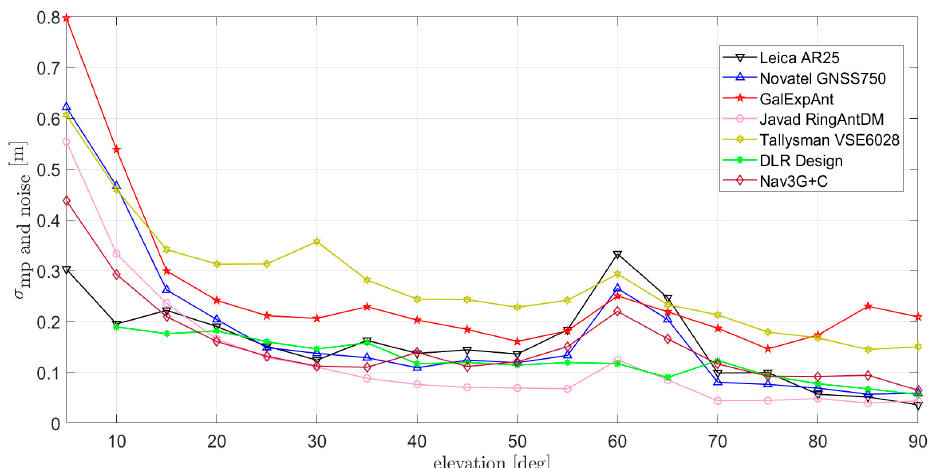
Figure 10. RMS of 100 s smoothed multipath (estimated through CMC) at L1/E1 for the antennas measured at DLR: (1) Leica AR25 R4; (2) Novatel GNSS-750; (3) Javad RingAnt-DM; (4) Space Engineering GalExpAnt; (5) DLR internal design; (6) Navxperience Nav3G+C; (7) Tallysman VSE6028 VeroStar.